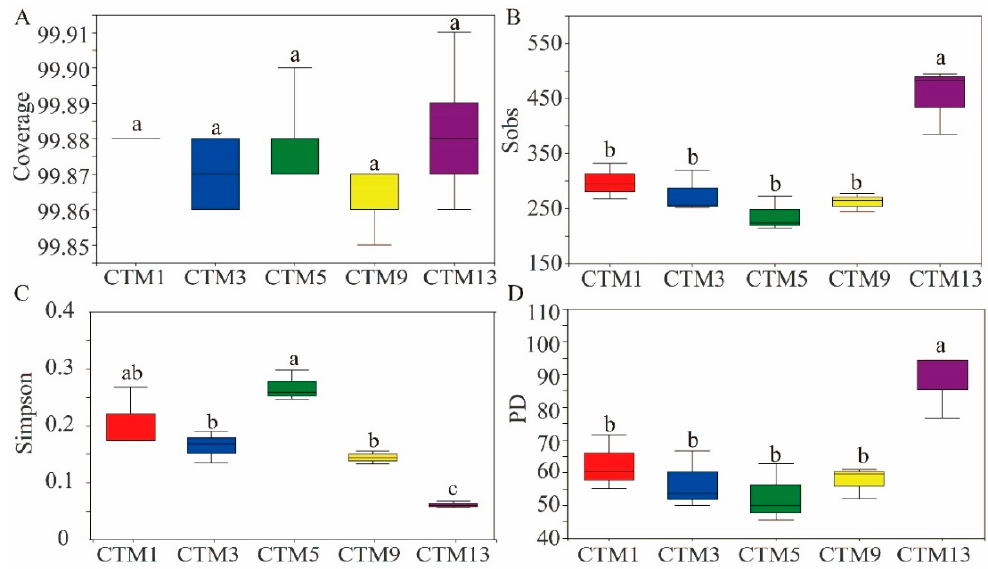
Figure 1. Soil fungal alpha-diversity indexes among different CTM cycles. ( A ) Coverage at the OTU level; ( B ) Sobs index at the OTU level; ( C ) Simpson index at the OTU level; ( D ) Phylogenetic diver- sity (PD) index at the OTU level; different letters above boxplots indicated a significant difference between treatments based on Student’s t -test ( p < 0.05).